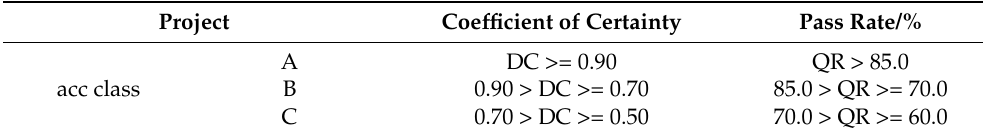
Table 1. Accuracy grades of forecast